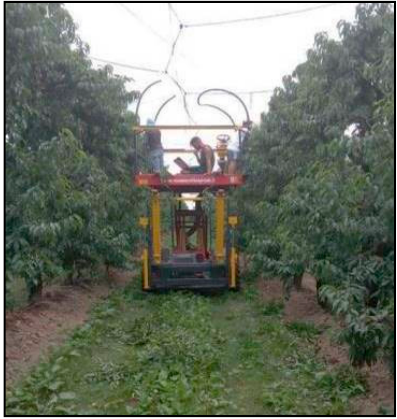
Figure 3. Recording of experimental data during summer pruning.